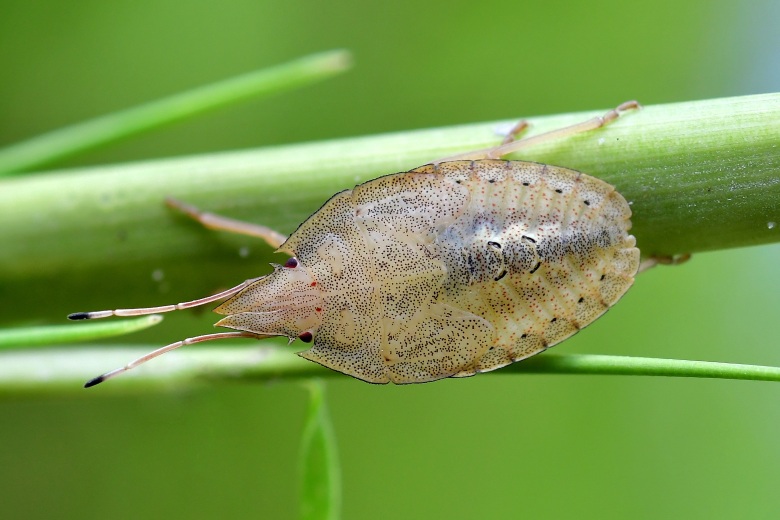
Fifth instar nymph.